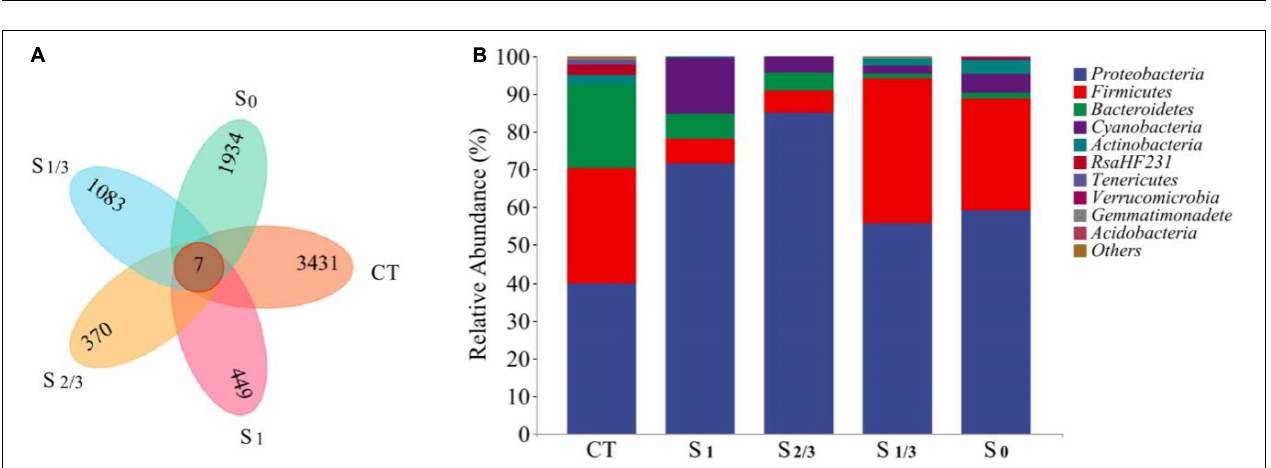
FIGURE 5 | Microbial community analysis of different samples: (A) Venn diagram of the distribution of OTUs. (B) The relative abundance of microbial communities at the phylum